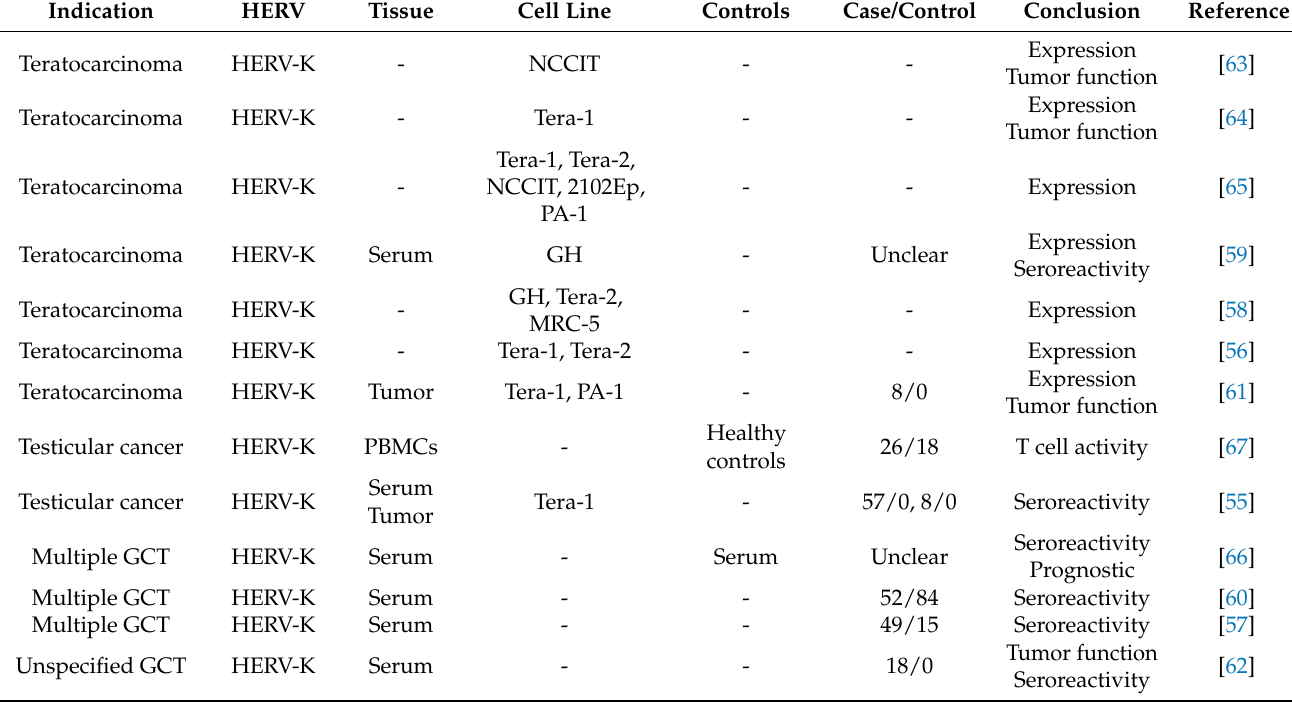
Table 1. HERV protein expression in germ cell